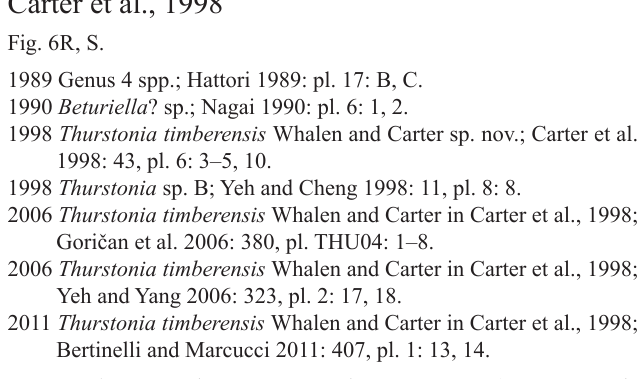
Fig. 7 . Radiolarians from Mount Rettenstein, Austria, Pliensbachian, Early Jurassic. A . Pseudoheliodiscus robustospinosus Kozur and Mostler, 1990, sample Rö37. B . Palaeosaturnalis liassicus Kozur and Mostler, 1990, sample Rö417. C , D . Palaeosaturnalis subovalis Kozur and Mostler, 1990, sam- ple Rö416. E . Stauracanthocircus asymmetricus Kozur and Mostler, 1990, sample Rö37. F . Palaeosaturnalis tetraradiatus (Kozur and Mostler, 1990), sample Rö417. G , H . Stauromesosaturnalis deweveri Kozur and Mostler, 1990, sample Rö97. I . Pseudoheliodiscus radiosus De Wever, 1981; sample Rö97. J – N . Praeconocaryomma bajaensis Whalen in Gori č an et al., 2006, sample Rö97. O – R . Praeconocaryomma decora gr. Yeh, 1987, s ample Rö97. S , T . Prae conocaryomma parvimamma Pessagno and Poisson, 1981, sample Rö97. U . Orbiculiformella sp. 1, sample Rö417. V . Crucella jadeae Carter and Dumitrica in Gori č an et al., 2006, sample Rö417. W . Crucella squama (Kozlova, 1971), sample Rö416. X . Crucella angulosa Carter in Carter et al., 1988, sample Rö416. Y , Z . Paronaella grahamensis Carter in Carter et al., 1988. Y . Sample Rö416. Z . Sample Rö37. AA . Paronaella corpulenta De Wever, 1981b, sample Rö38. AB , AC . Beatricea ? argescens (Cordey, 1998), sample